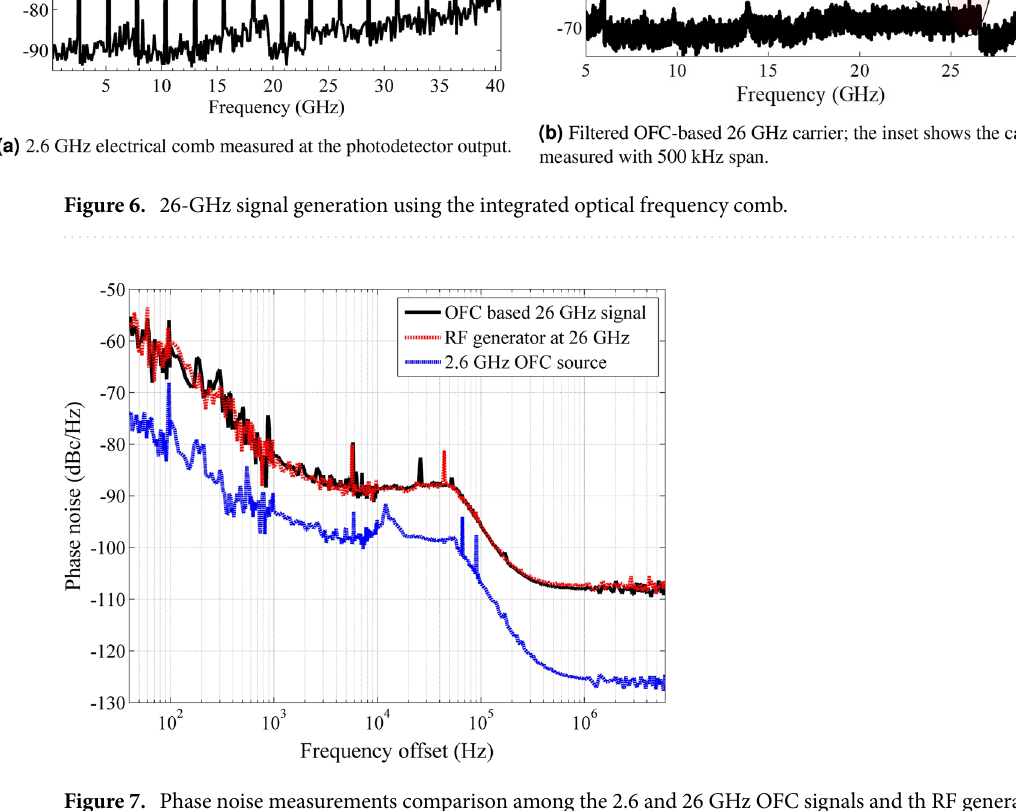
Figure 7. Phase noise measurements comparison among the 2.6 and 26 GHz OFC signals and th RF generator at 26